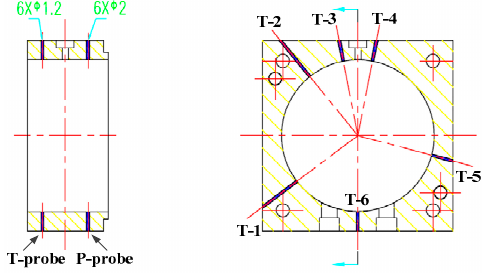
Figure 27. Distribution of parameter-measuring points.